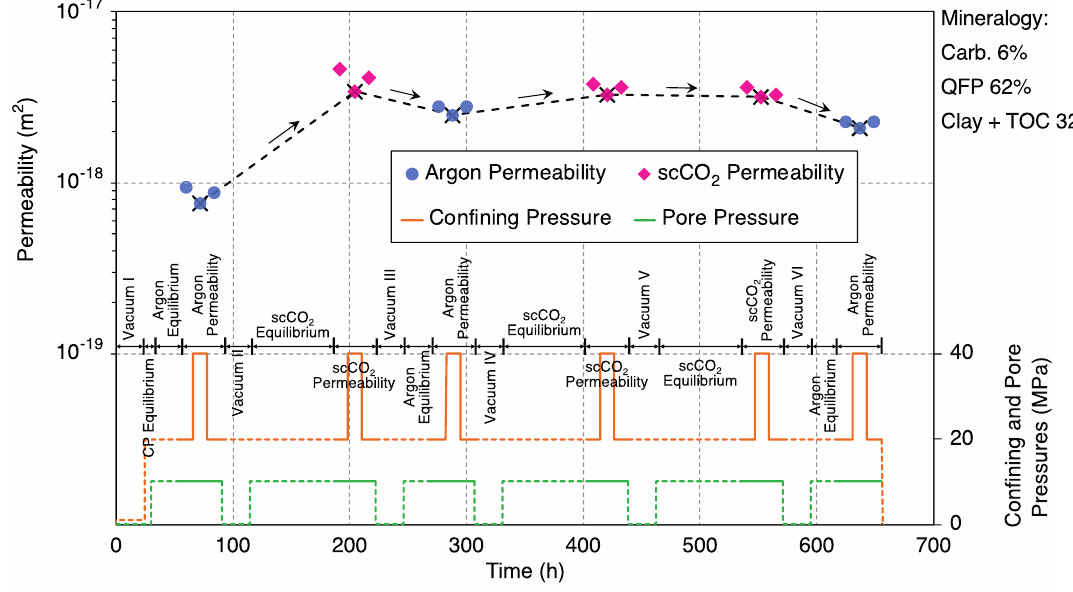
Figure 5. Permeability changes for sample 4-2H.